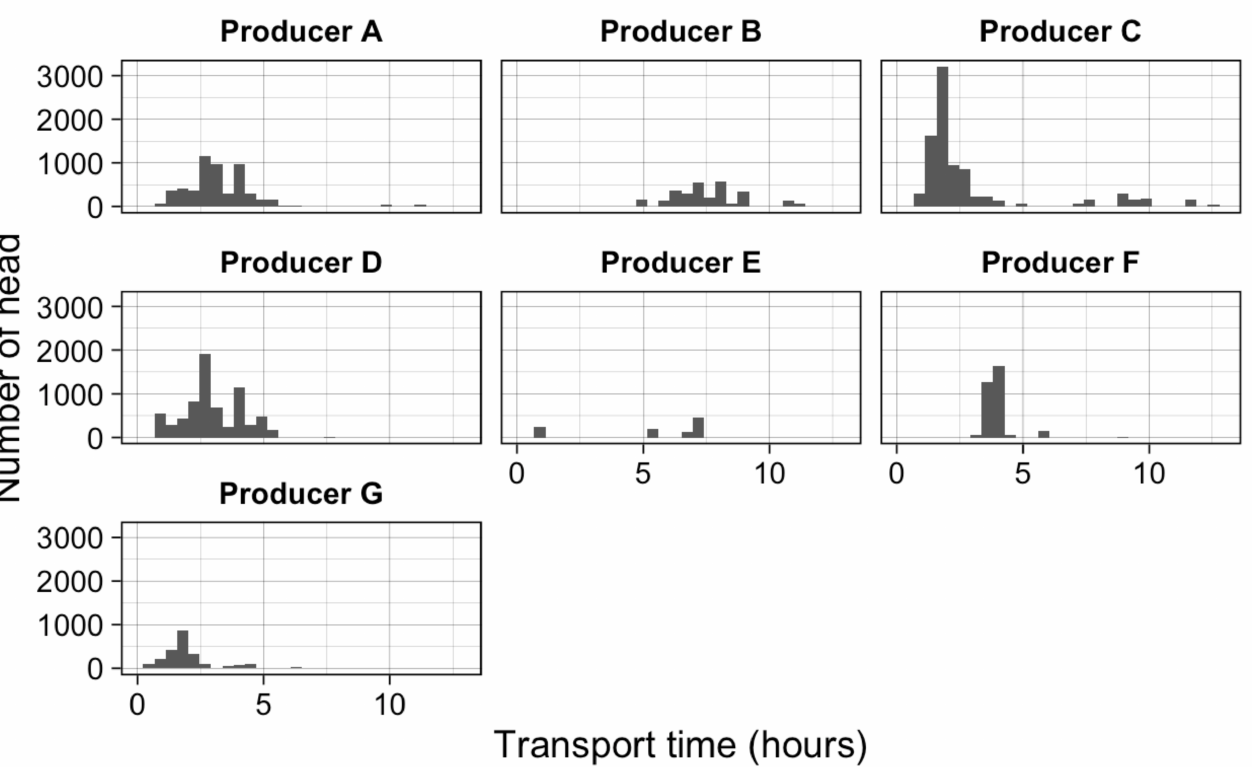
Figure 1. Transport duration (hours) for all